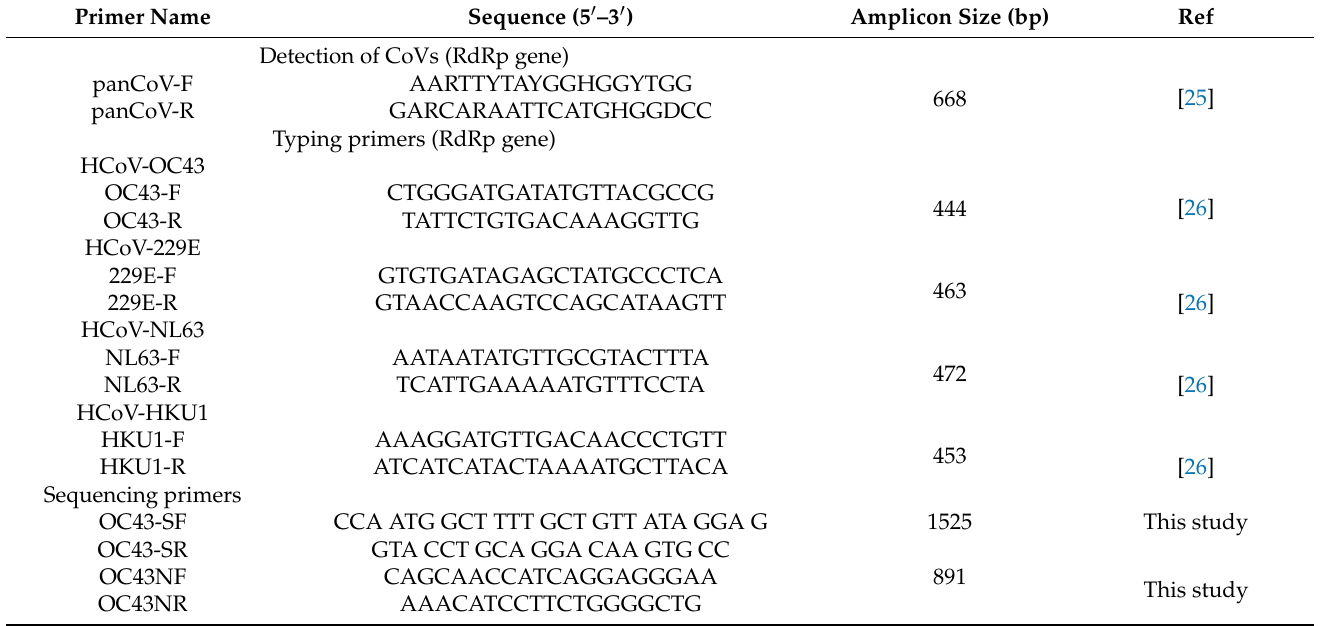
Table 1. Oligonucleotide primers used in the study for detection, typing, and sequencing of sea- sonal